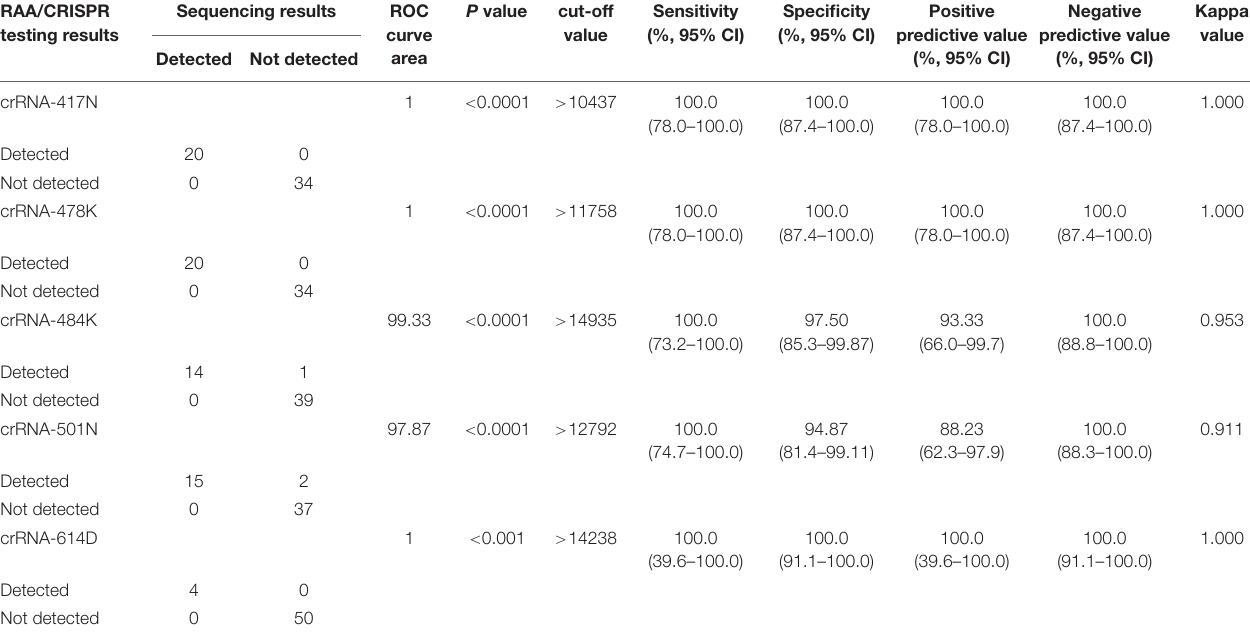
TABLE 2 | Concordance between RAA/CRISPR-Cas12a-based assay and Sanger sequencing. RAA/CRISPR testing